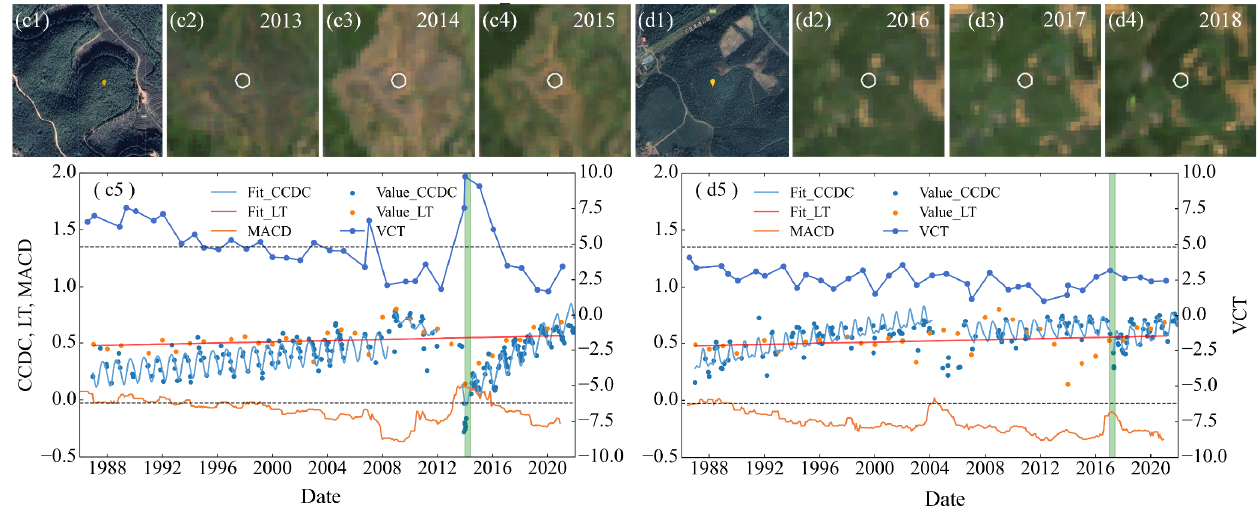
Figure 4. Detection of forest regrowth using the moving average change detection (MACD), Con- tinuous Change Detection and Classification (CCDC), LandTrendr (LT), and Vegetation Change Tracker (VCT) algorithms for four forest sampling plots ( a1 ) 25°50 ′ 39.12 ″ N, 114°8 ′ 39.48 ″ E; ( b1 ) 27°53 ′ 26.16 ″ N, 116°28 ′ 45.84 ″ E; ( c1 ) 24°47 ′ 57.48 ″ N, 114°52 ′ 59.52 ″ E; ( d1 ) 27°45 ′ 47.09 ″ N, 114°9 ′ 19.08 ″ E. ( a5 , b5 , c5 , d5 ):The left y-axis represents CCDC, LT, and MACD, whereas the right y-axis represents VCT. The thresholds of VCT and MACD are the upper and lower black dashed lines, respectively. ( a2 – a4 , b2 – b4 , c2 – c4 , d2 – d4 ): The red–blue–green (RGB) images were composed of the red, green, and blue bands from Landsat images.